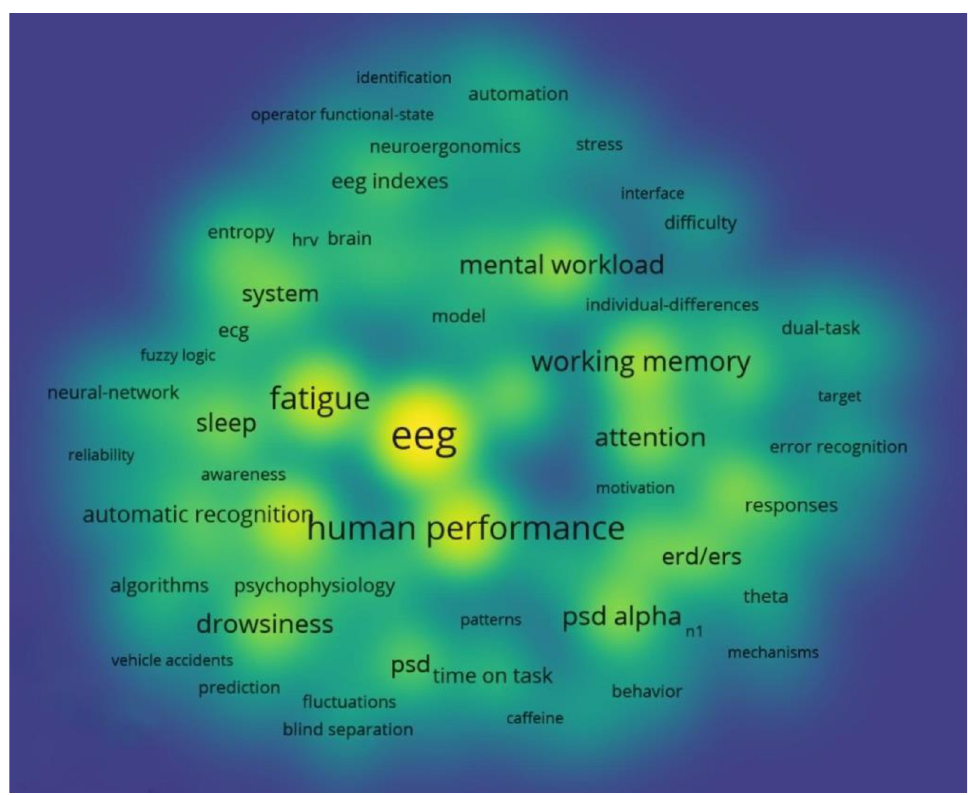
Fig 8. Density view of a network visualization map showing co-occurrence of title and abstract keywords.